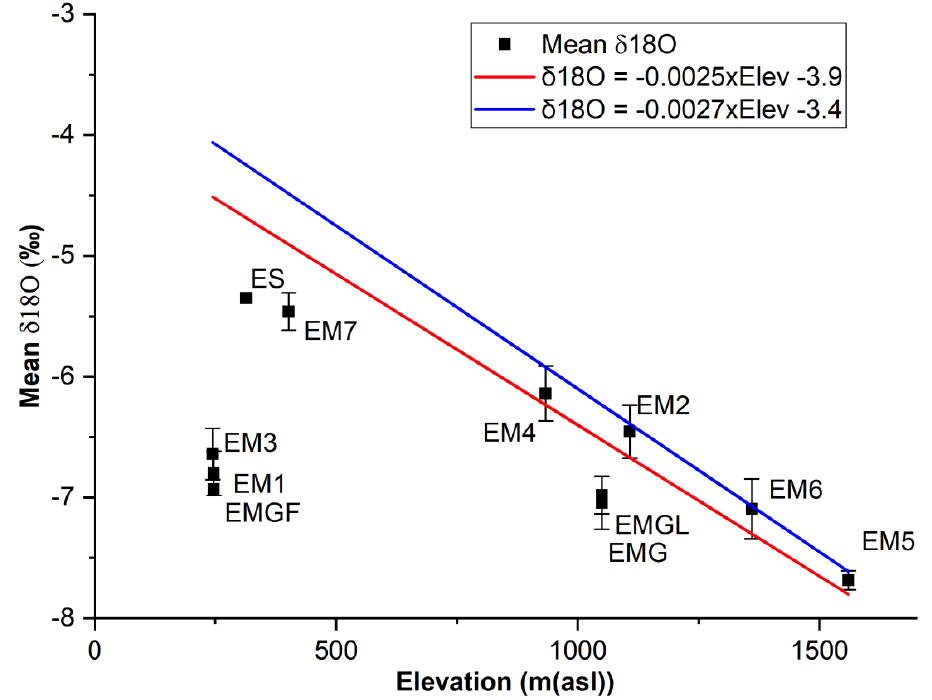
Figure 11. Relationship between the altitude and water δ 18 O values. Blue line: the isotopic altitudinal gradient of Morocco; red line: the isotopic altitudinal gradient of the Middle Atlas.